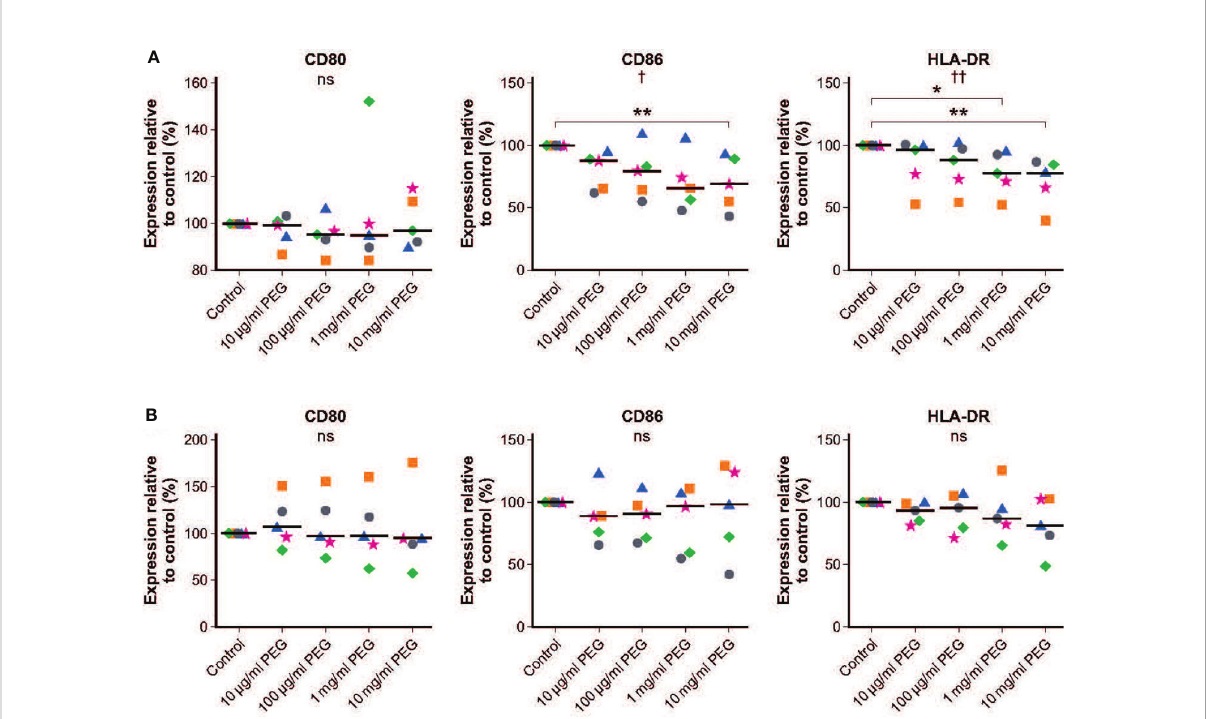
FIGURE 5 Effect of 20-kDa PEG exposure on cell surface markers of human MDMs. (A) Expression in resting MDMs after 24 hours of PEG exposure (n = 5). (B) Expression in LPS-stimulated MDMs after 24 hours of PEG exposure (n = 5). Data shown as individual values relative to control, with the horizontal line indicating the median. † p = 0.0229, †† p = 0.0024, ns not signi fi cant (one-way ANOVA/Friedman ’ s Test); CD86: ** p = 0.0014; HLA- DR: * p = 0.0051, ** p = 0.0007 versus control ( post-hoc test: Dunn ’ s multiple comparisons). ANOVA, analysis of variance; LPS,